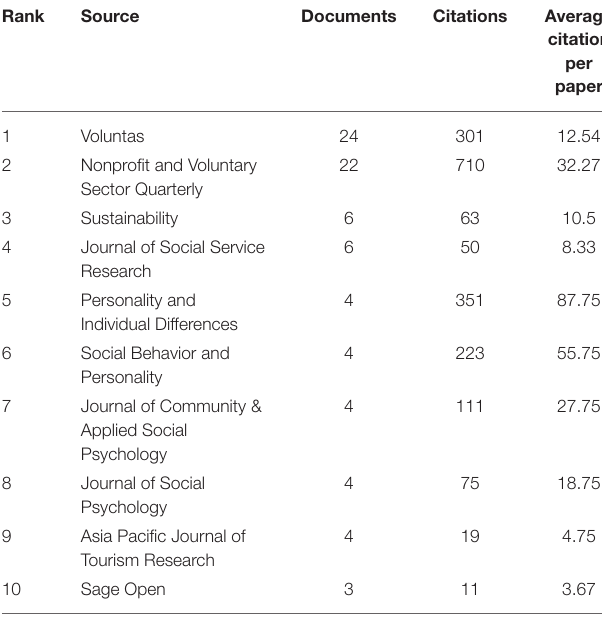
TABLE 7 | Top 10 influential organizations in volunteer motivation research. TABLE 8 | Top 10 journals in the volunteer motivation research